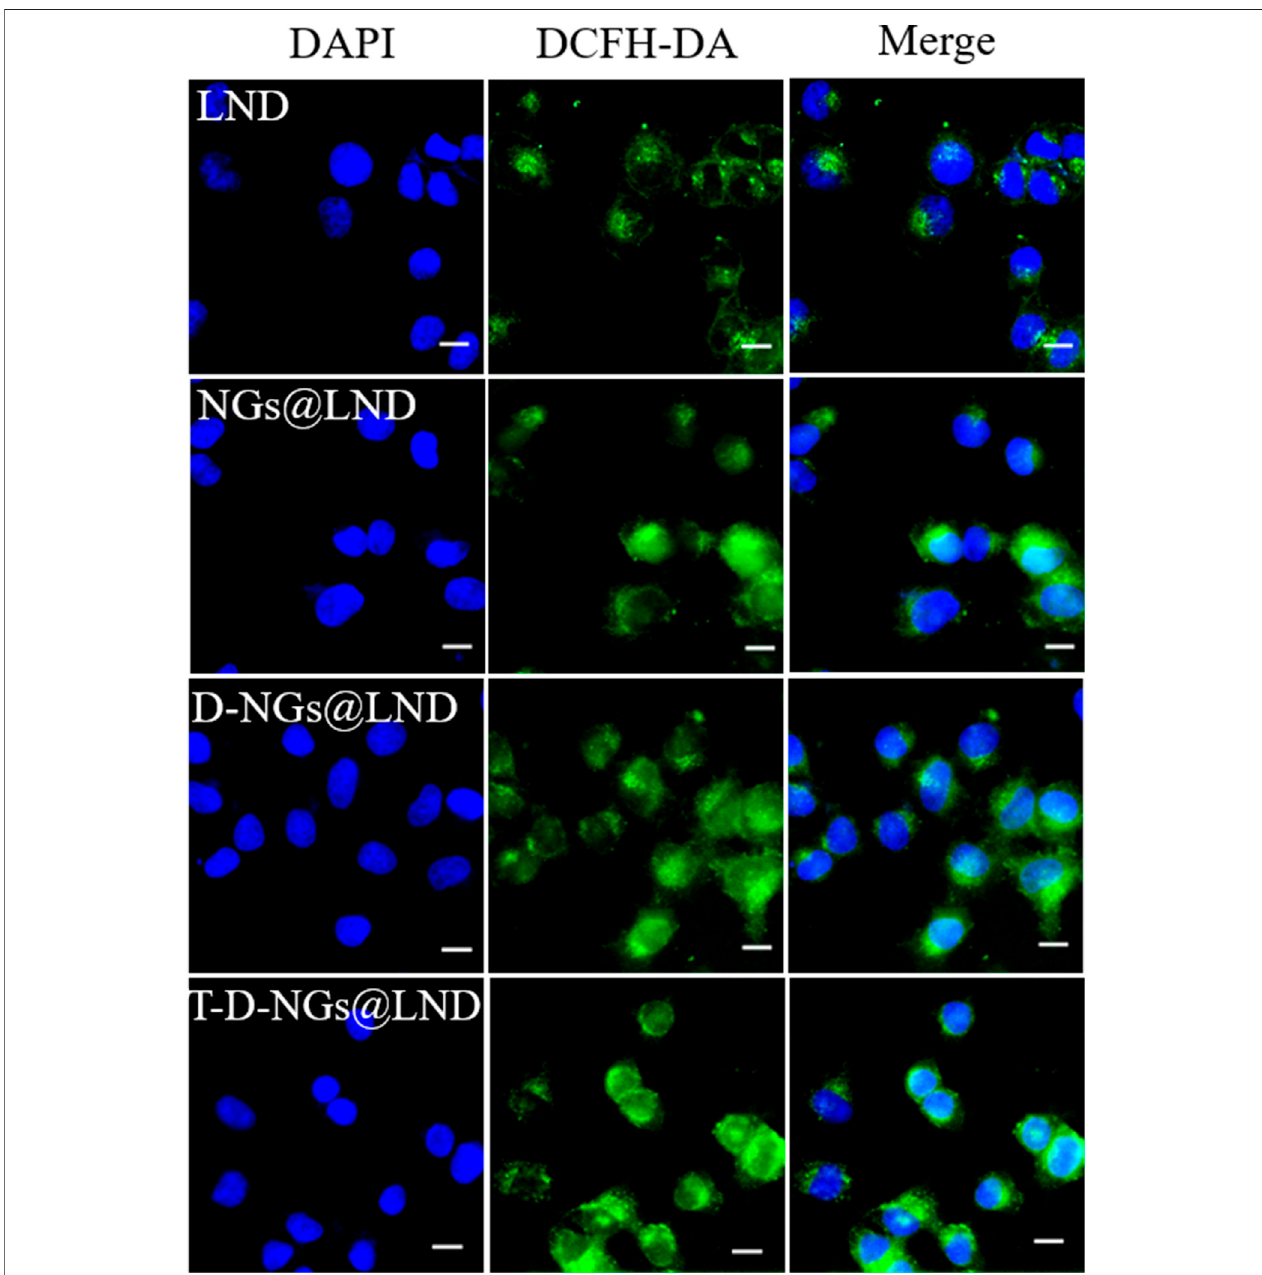
FIGURE 6 | Intracellular ROS level in MCF-7/MDR cells receiving LND, NGs@LND, D-NGs@LND, and T-D-NGs@LND for 12 h using a probe of DCFH-DA. Scale bars: 20 μ m. ROS, reactive oxygen species; DCFH-DA, dichlorodihydro- fl uorescein diacetate.